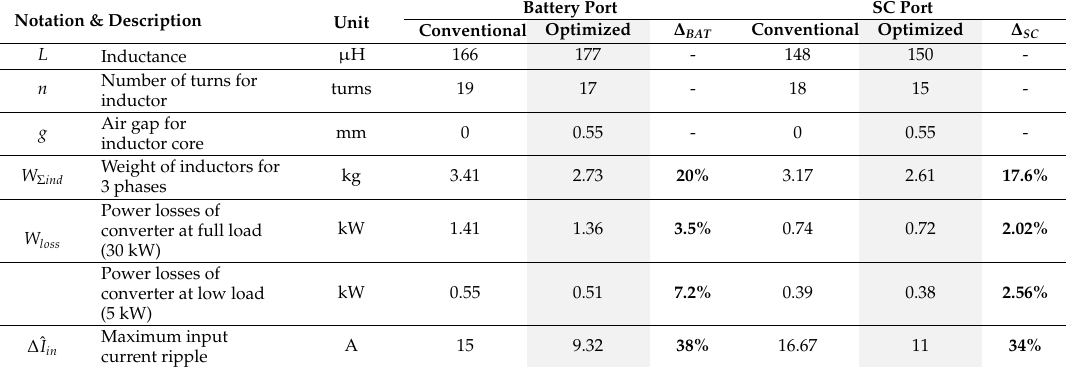
Table 4. Comparison between the conventional and optimized design for Battery and SC